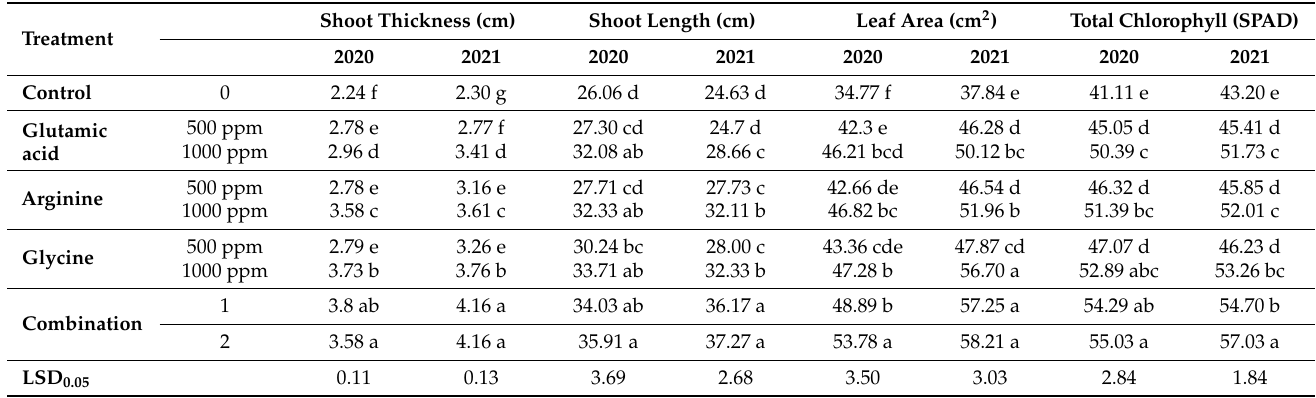
Table 2. The influence of glutamic acid, arginine, and glycine amino acids on shoot thickness, shoot length, leaf area, and leaf total chlorophyll of guava during the 2020 and 2021 seasons. Shoot Thickness